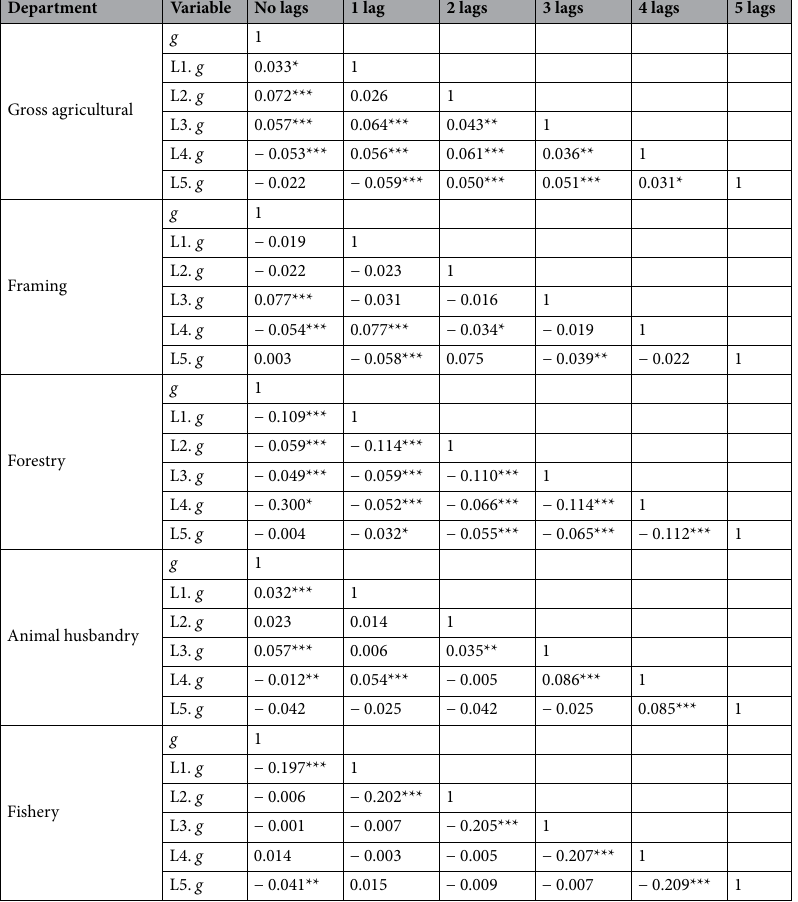
Table 2. Correlation statistics. ***, **, * indicate significant at the statistical level of 1%, 5%, and 10%, respectively.